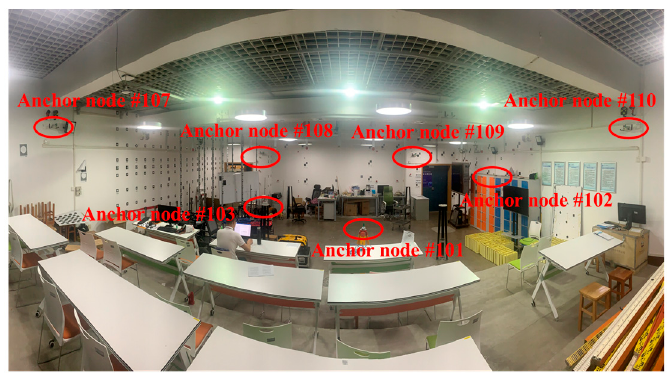
Figure 4. Anchor nodes arrangement in our laboratory.